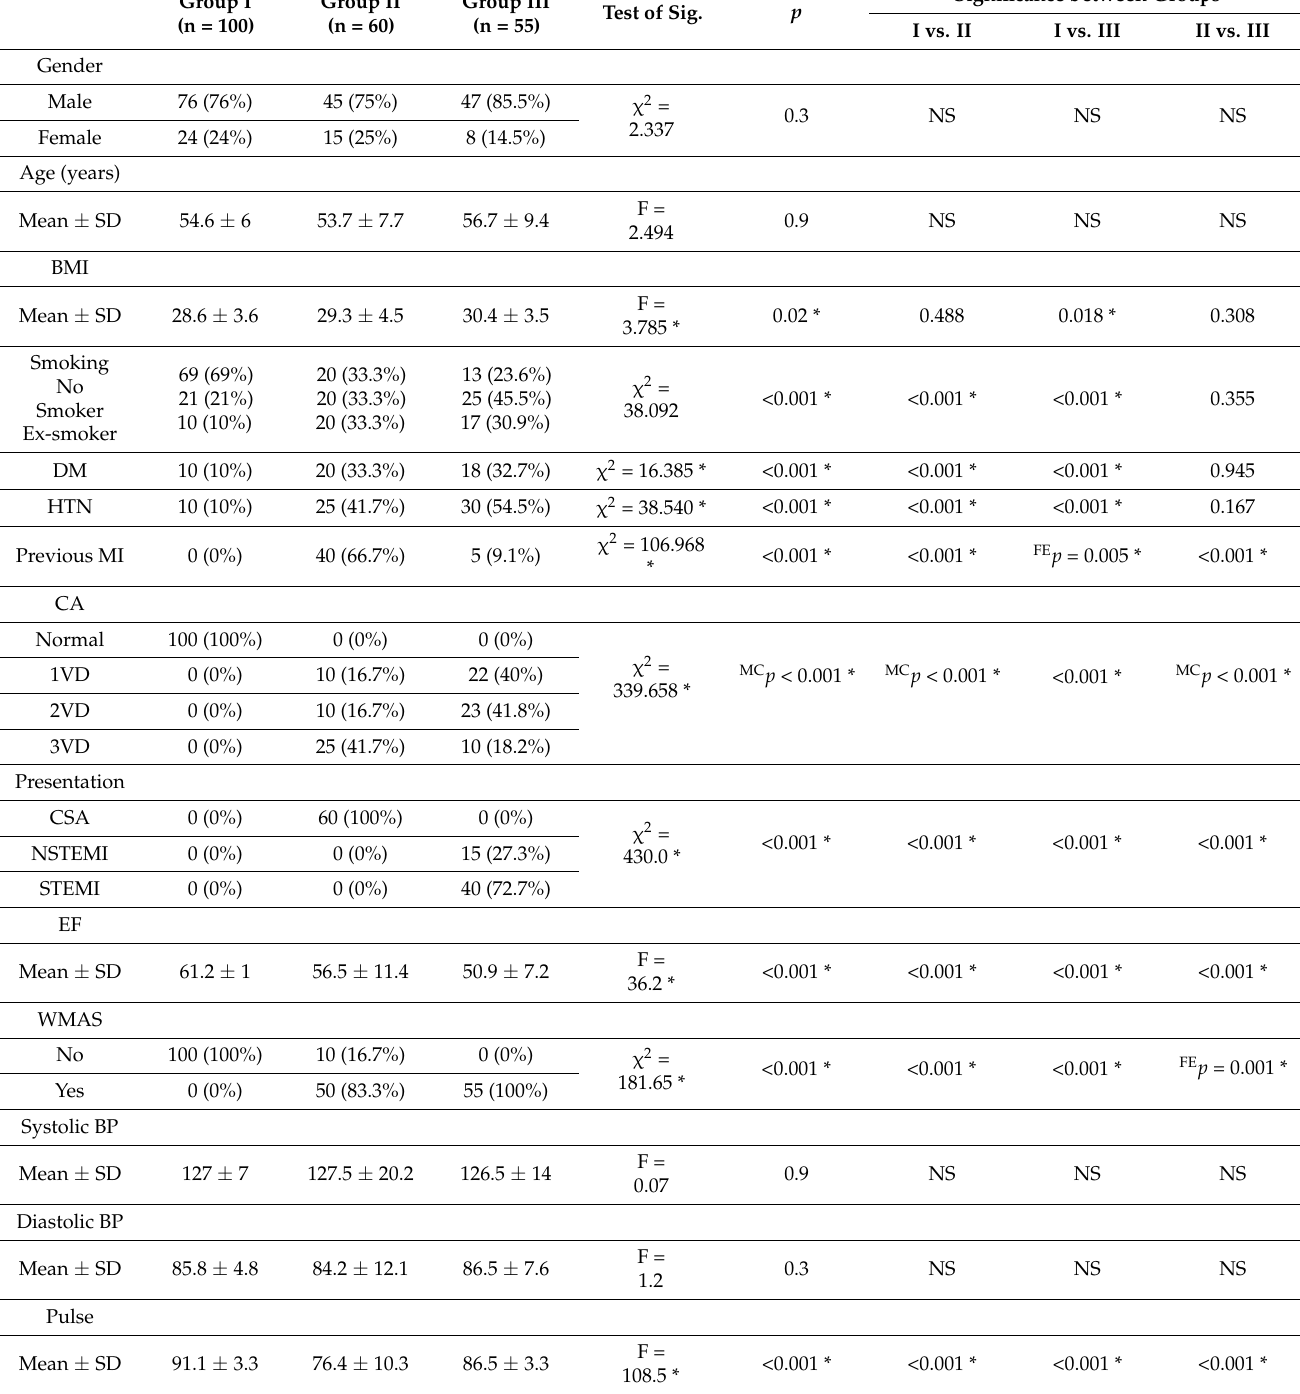
Table 1. Comparison of the involved groups based upon demographic and clinical